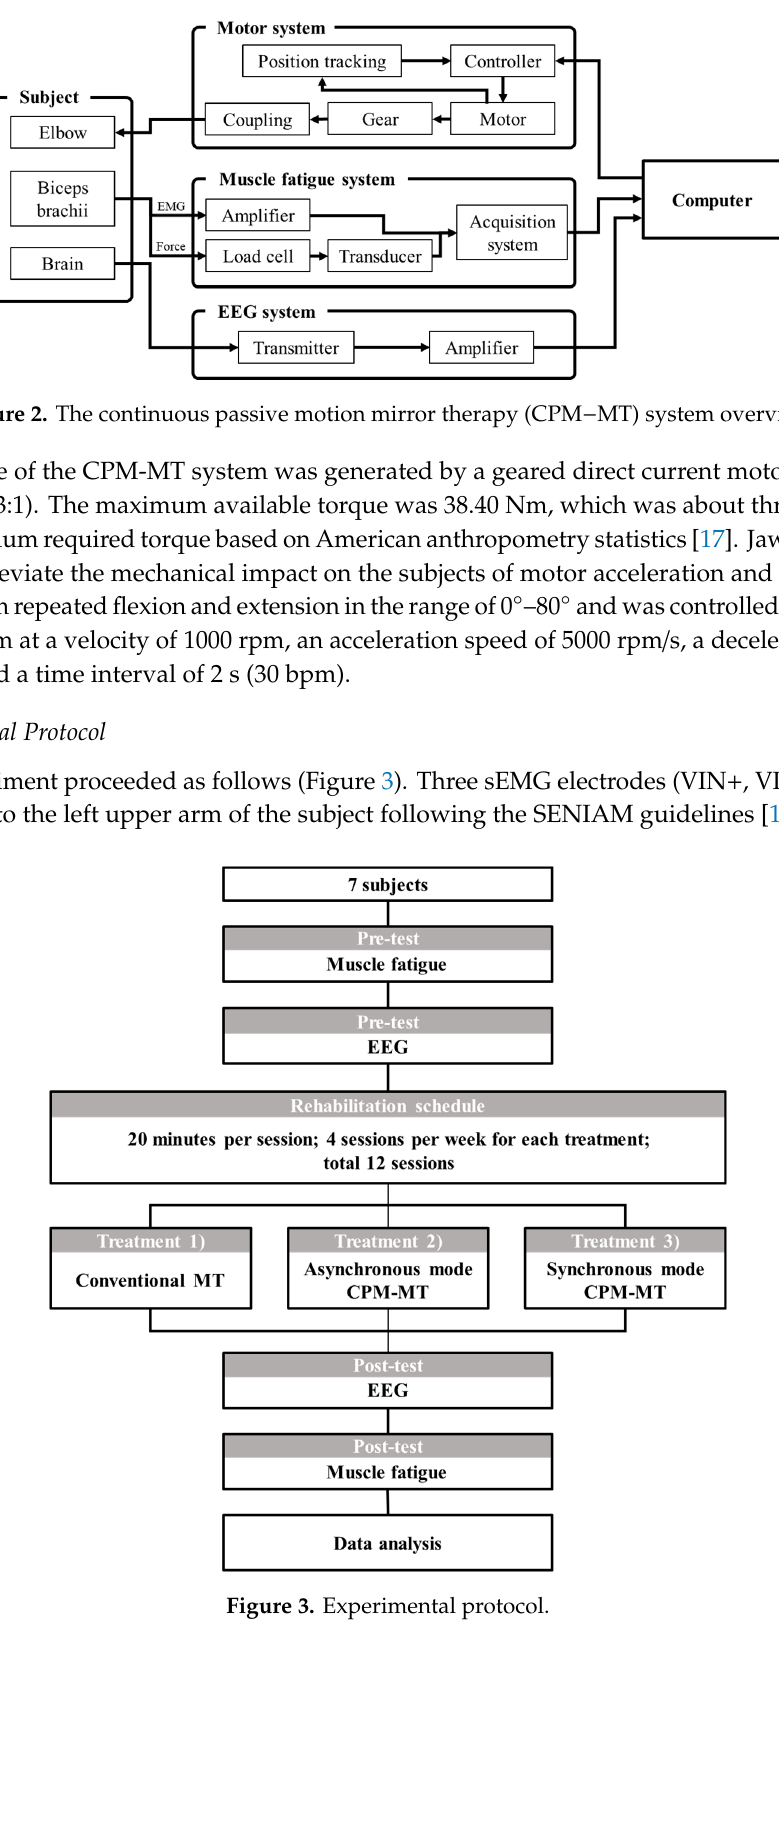
Figure 3. Experimental protocol.